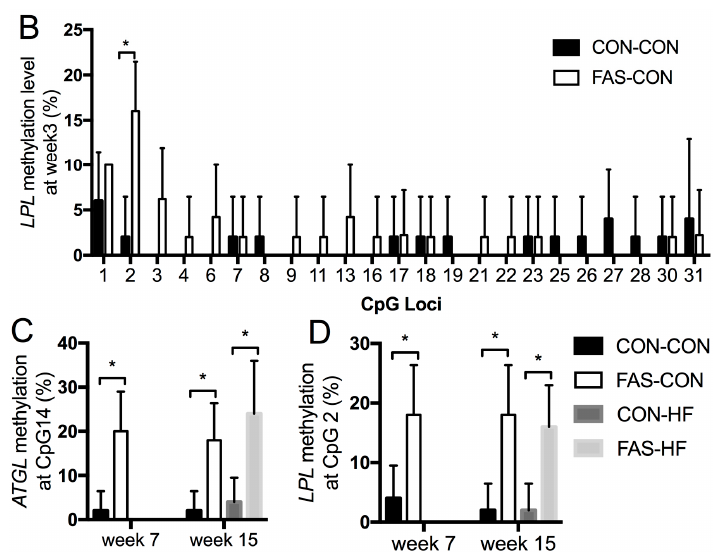
Figure 5. DNA methylation of: hepatic ATGL ( A , C ); and adipose LPL ( B , D ) at Weeks of 3, 7, and 15. Values are means with standard deviations ( n = 10). * The difference between the two groups indicated by the line segment is significant, p < 0.05.